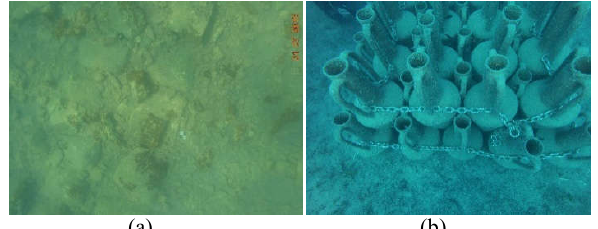
Figure 1. Sample images from shallow waters dataset (a) and